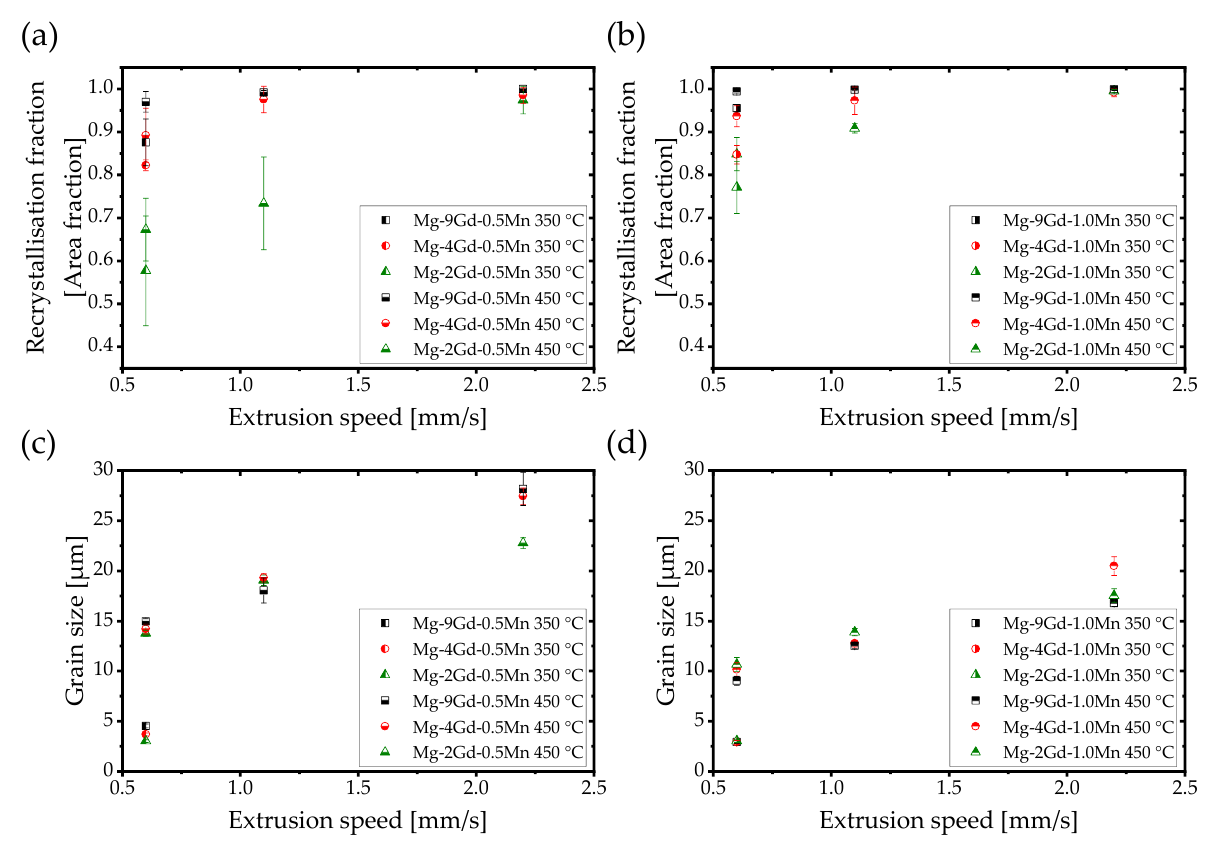
Figure 4. Degree of recrystallization for Mg-xGd-0.5Mn ( a ) and for Mg-xGd-0.5Mn ( b ) and grain size with respect to extrusion parameters for Mg-xGd-0.5Mn ( c ) and for Mg-xGd-0.5Mn ( d ). Error bars are standard deviations.